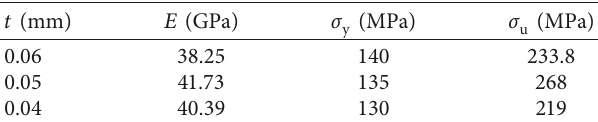
Figure 8: Stress-strain curve of aluminum foils with a thickness of 0.06mm. Table 1: Experimental results from tension experiments.